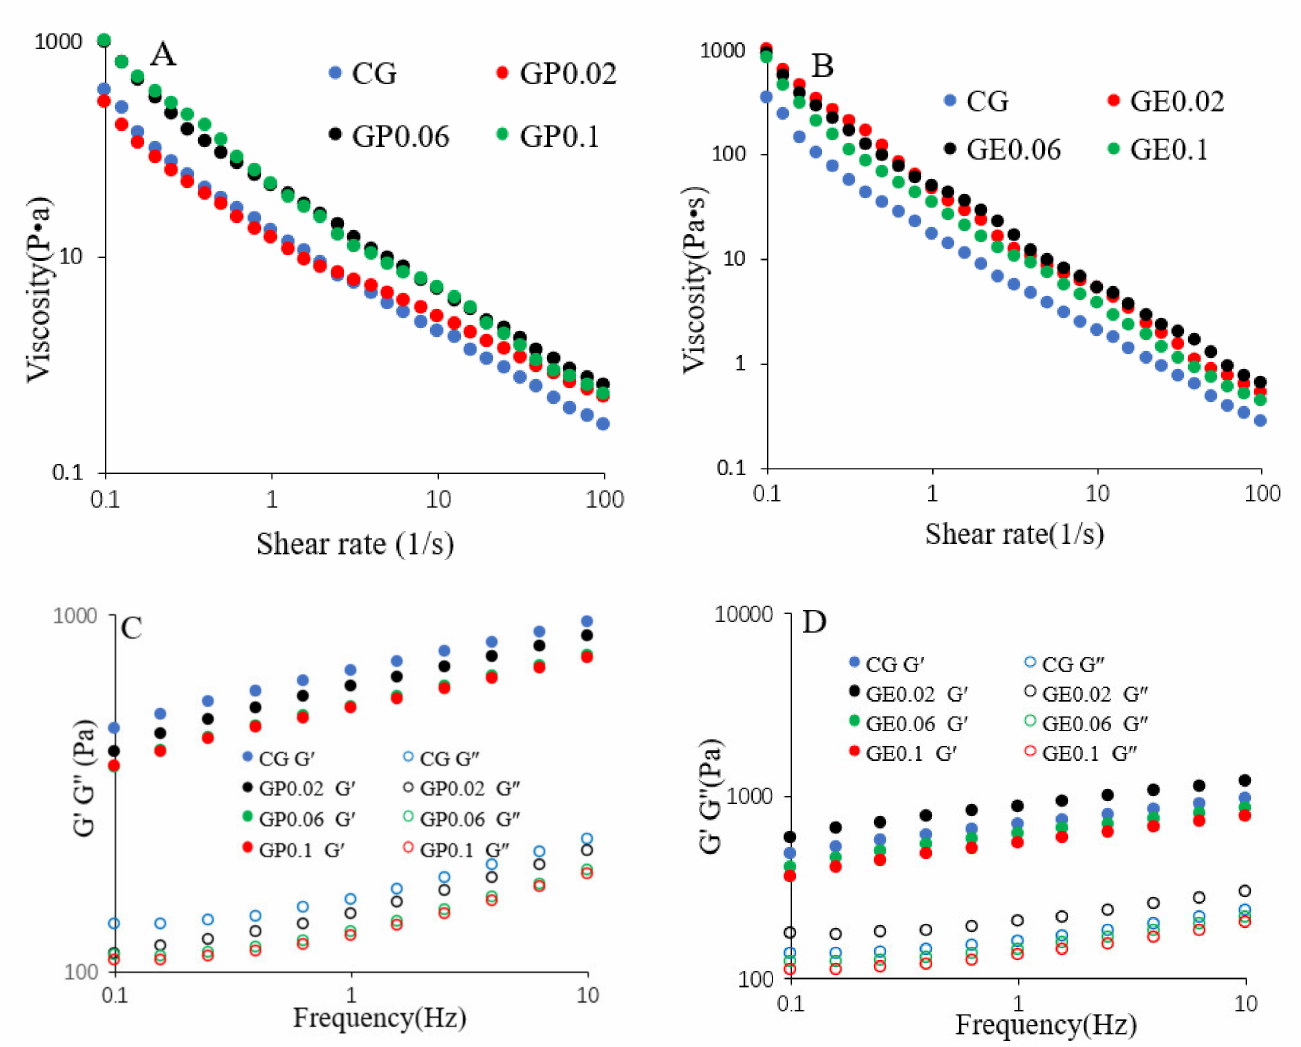
Figure 3. Rheological characterization of the yogurts. ( A , B ) Flow behavior and ( C , D ) storage modu lus (G (cid:48) ) and loss modulus (G (cid:48)(cid:48)